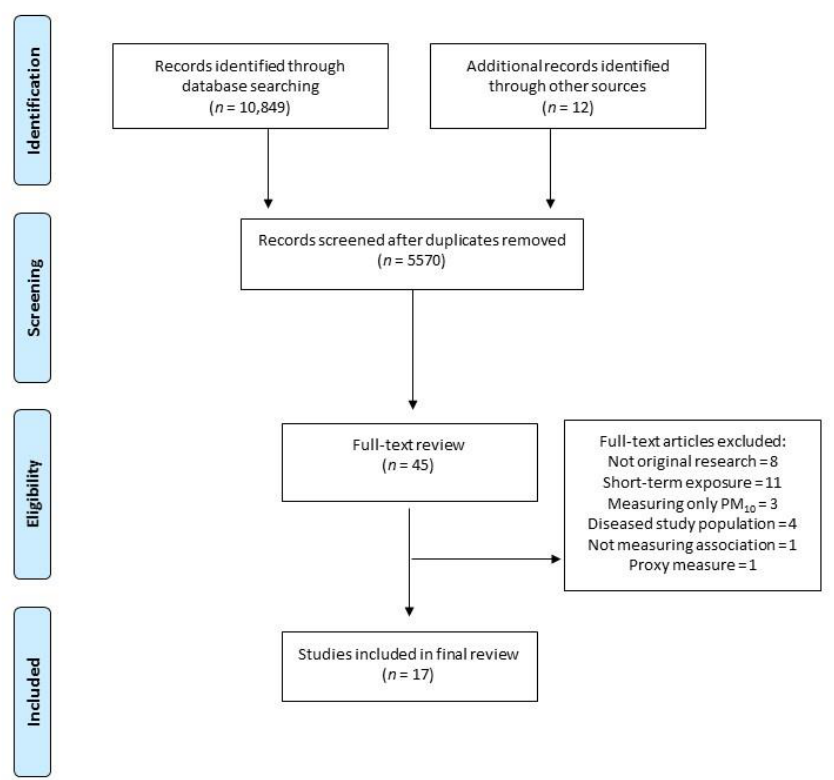
Figure 1. PRISMA flowchart